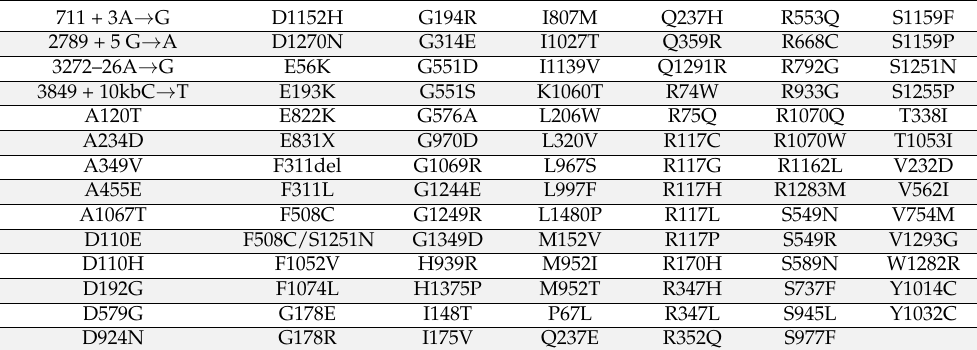
Table 2. List of CFTR mutations eligible for the treatment with Ivacaftor and approved by the FDA. Available from https://www.vertexgps.com, accessed on 14 November 2022.